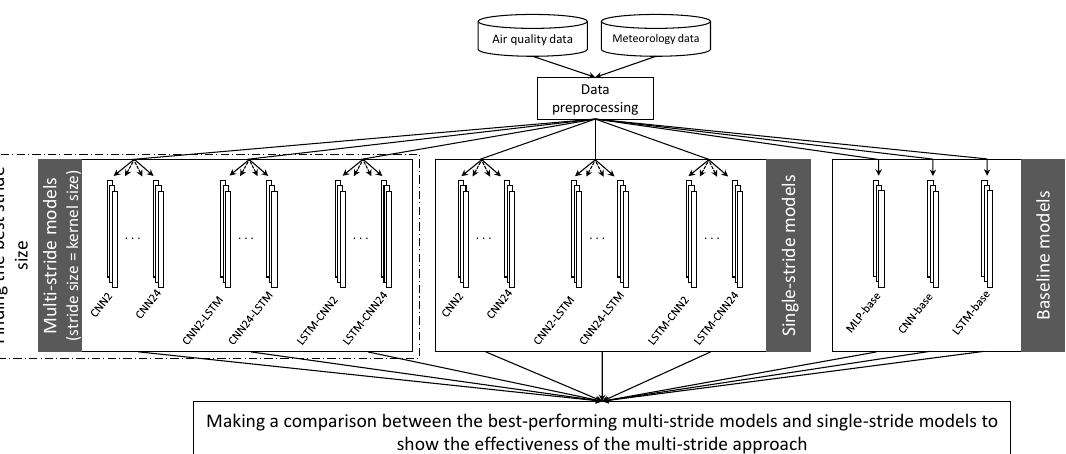
Figure 7. Conceptual framework of the